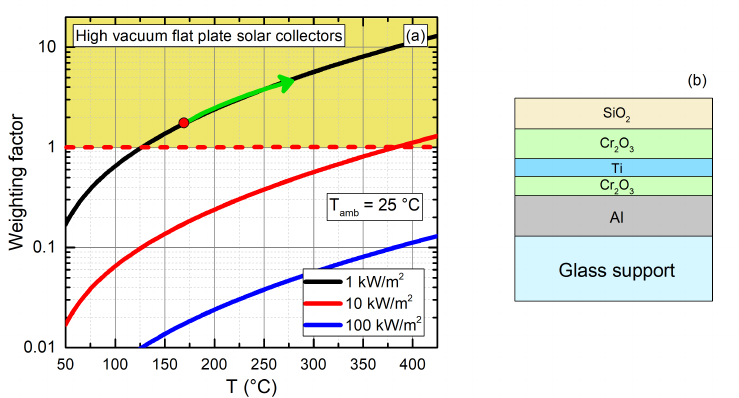
Figure 1. ( a ) Weighting factor versus absorber temperature T ( ◦ C) for different solar concentration ratios. The red dot indicates the operating temperature (160 ◦ C) of High Vacuum insulated Flat plate solar thermal Panel (HVFP) equipped with commercial absorber and the green arrow the increasing importance of thermal emittance with working temperature (adapted from [13]). ( b ) Schematic structure of the multilayer under study. From bottom to top: glass substrate, aluminum film (250 nm) and its natural oxide, Chromium oxide Cr 2 O 3 , Titanium Ti, Chromium oxide Cr 2 O 3 and silicon dioxide SiO 2